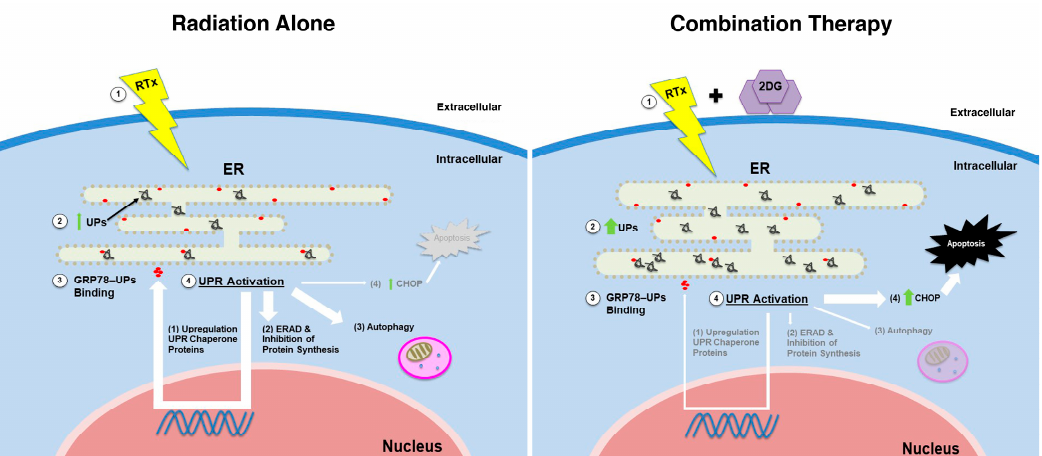
Figure 7. Graphic depiction of intracellular unfolded protein (UPR) activation induced by radiation versus radiation plus 2-deoxy- D -glucose (2-DG) on GSCs. Left panel : (1) Radiation induces accumulation of (2) unfolded proteins (UPs) in the endoplasmic reticulum (ER). This leads to release of the folding chaperone protein, GRP78, from PERK, IRE1, and ATF6 found on the ER membrane and (3) binding of GRP78 to UPs. GRP78 release activates PERK, IRE1, and ATF6 and (4) promotes UPR. Effects of activation include increased expression of chaperone proteins, ER associated protein degradation (ERAD), and autophagy, but limited apoptosis via CHOP upregulation. Right panel : (1) Radiation and 2-DG induce increased levels of ER stress and (2) higher levels of UPs. GRP78 binding to UPs and UPR activation follows (3,4); however, combination therapy induces higher ER stress than radiation alone, which prompt GSCs towards CHOP-associated apoptosis. Abbreviations: 2-DG, 2-deoxy-d-glucose; ER, endoplasmic reticulum; ERAD, ER-associated degradation; RTx, radiation; UP, unfolded proteins; UPR, unfolded protein response.